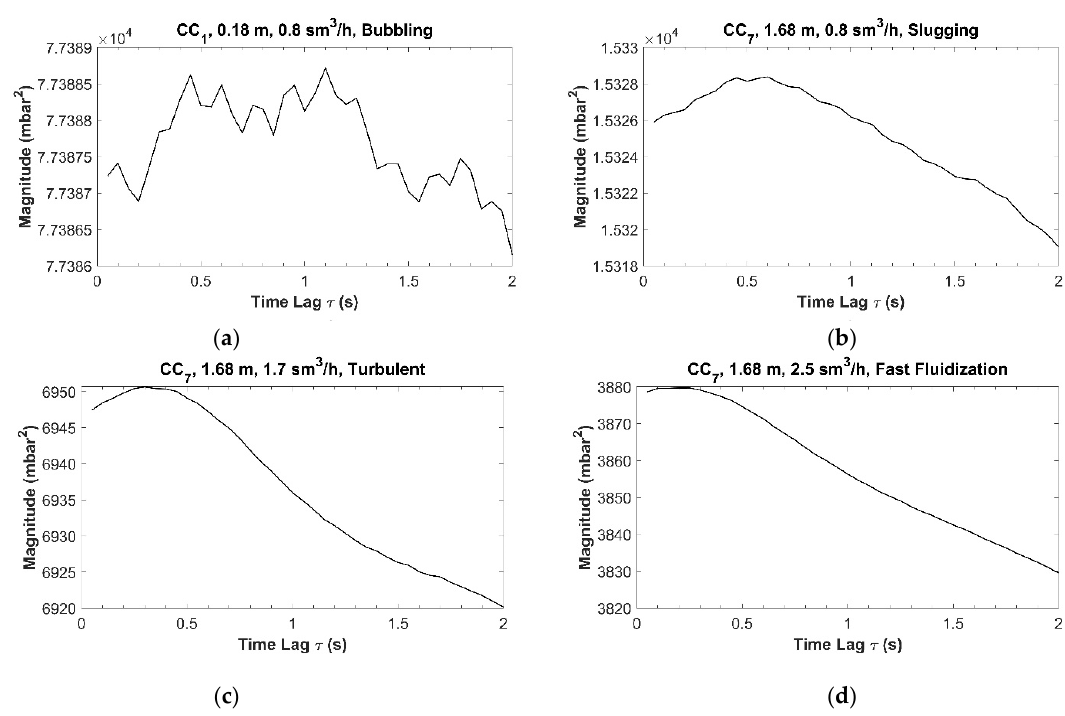
Figure 15. Several cross ‐ correlation functions corresponding to different fluidization regimes in the tube, at various heights and aeration flow rates: ( a ) single bubbling, ( b ) wall ‐ slugging, ( c ) turbulent, and ( d ) fast fluidization.